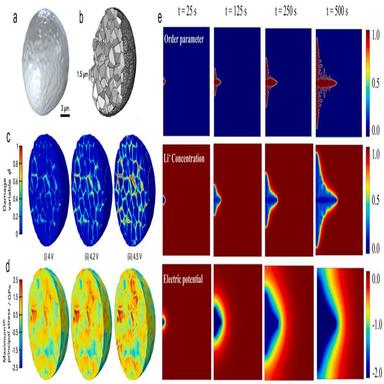
(a) Single particle electrode extracted from X-ray CT. (b) Cut-out of the underlying agglomerate microstructure comprising 400 primary particles. Phase-field simulations of (c) damage variable and (d) maximum principal stress profiles at a centre cross-section of the particle. Reproduced with permission from Royal Society of Chemistry. (e) Phase-field simulations of order parameter, Li+ concentration, and electric potential in Li dendrite growth. Reproduced with permission from E